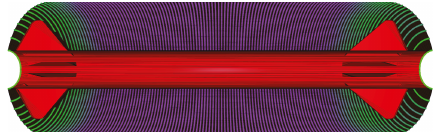
Figure 7: D on a sampling point set.